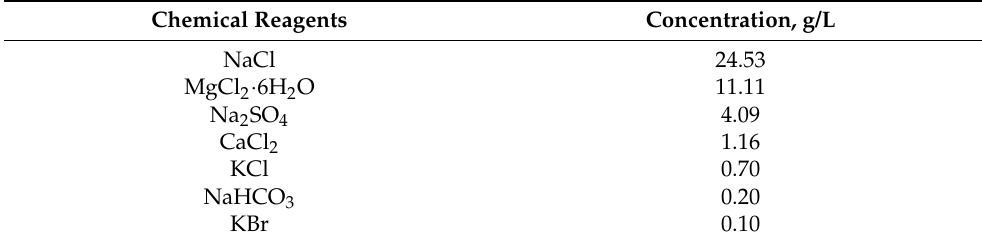
Table 1. Composition of the artificial seawater